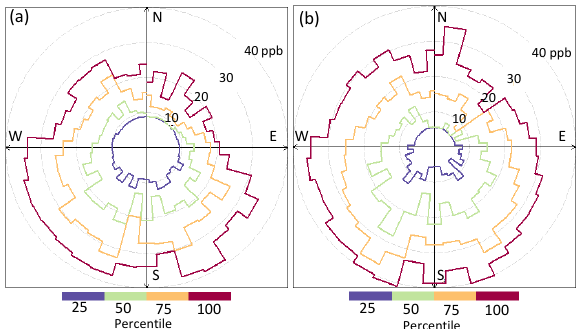
Figure 4. Example ozone (ppb) percentile rose plots between near- road sensor node (a) and NCore co-located node (b) for hourly FEM-corrected ozone between August 2014 and early March